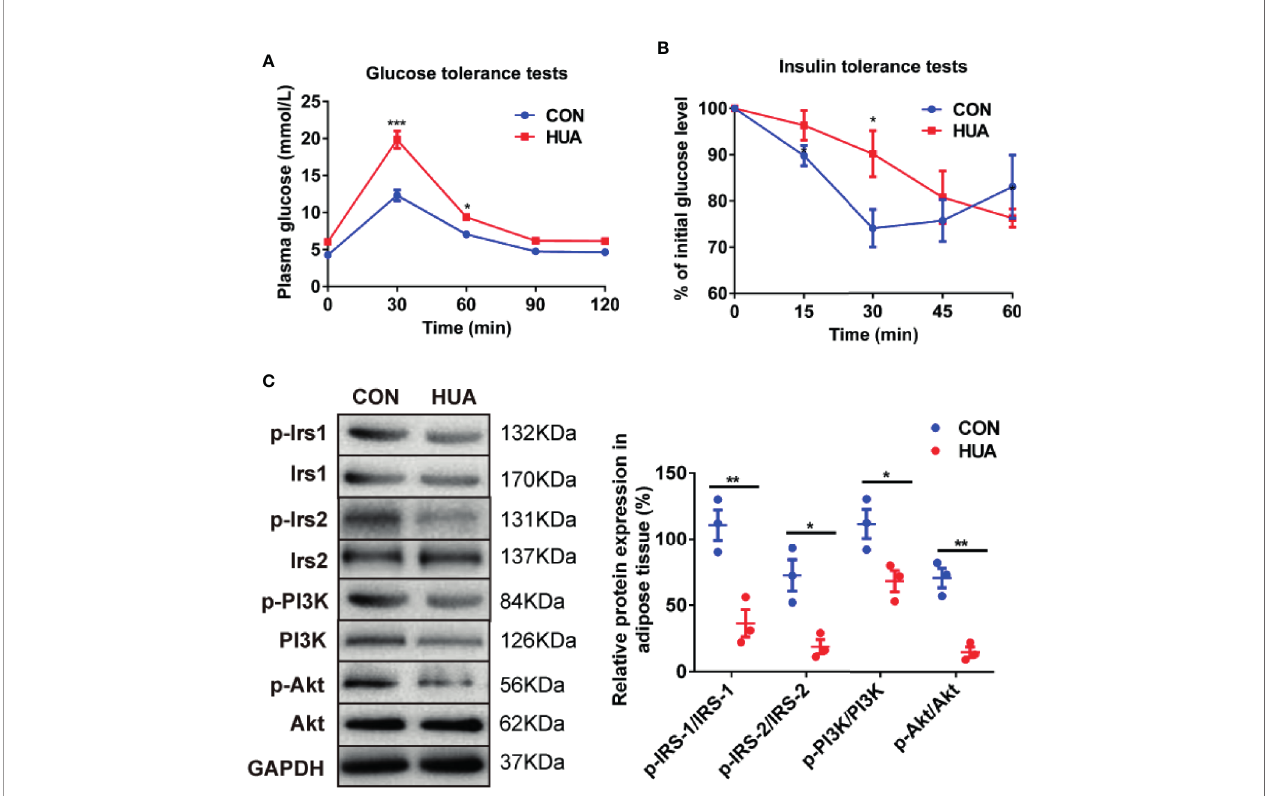
FIGURE 2 | Glucose tolerance and insulin tolerance in HUA rats. (A) Glucose tolerance tests were performed to detect glucose tolerance in HUA and CON rats (n = 10 per group). (B) Insulin tolerance tests were performed to detect glucose tolerance in HUA and control rats. (C) About 30 m g protein were loaded and the expression of p-IRS-1 (PY896), p-IRS-2 (S731), p-PI3K (P85), and p-Akt (Ser473) were measured by Western blot in the adipose tissue of HUA and CON rats. The representative views are shown in the left panel and densitrometric quanti fi cation analysis for RBP4 is shown in the right panel. Results are represented by mean ± SEM. * P < 0.05, ** P < 0.01, *** P <